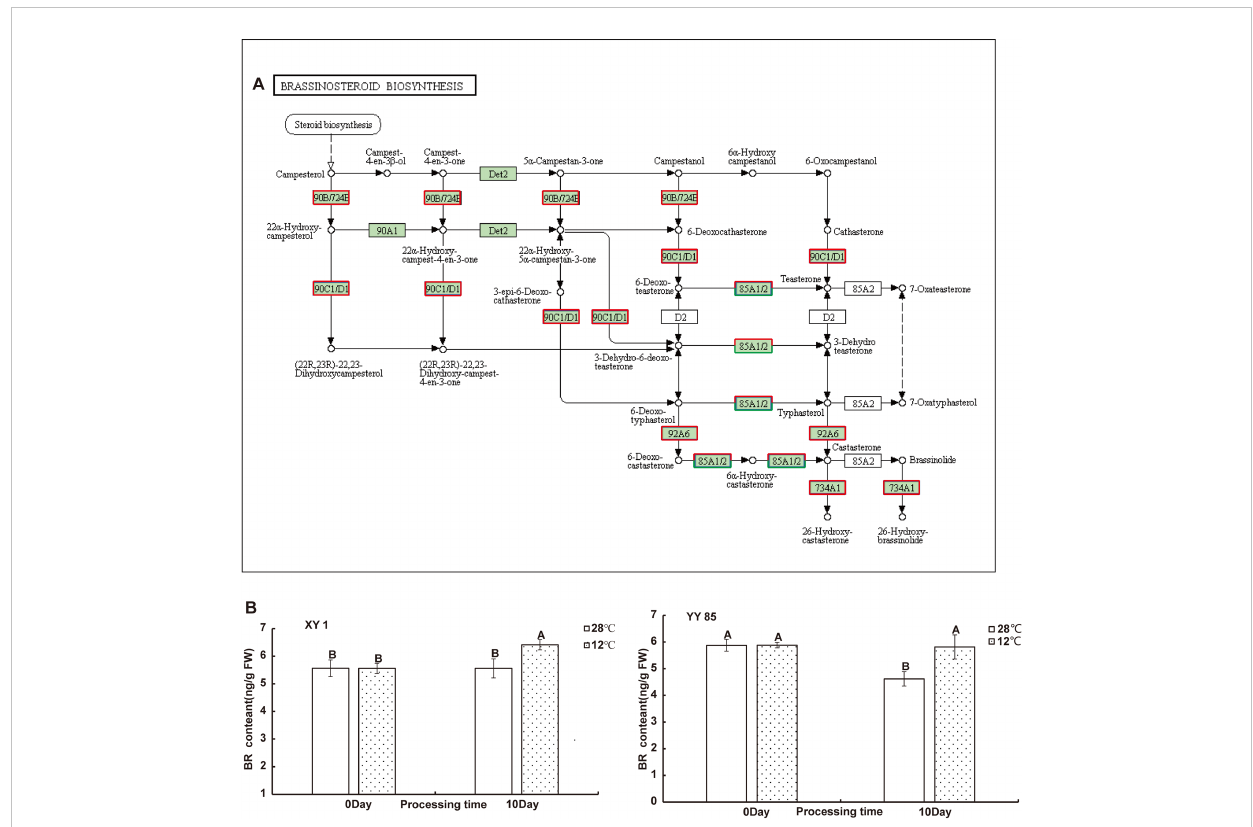
FIGURE 4 Integrated pathway mapping of BRs biosynthesis related DEGs. (A) DEGs were selected based on the KEGG enrichment (Red indicates up-regulated and green indicates down-regulated). (B) BR content in different species responding to cold treatment. Data are shown as the mean ± SD from three independent experiment replicates. Different letters indicated signi fi cant different (P<0.05, Tukey ’ s test). NS, no signi fi cant